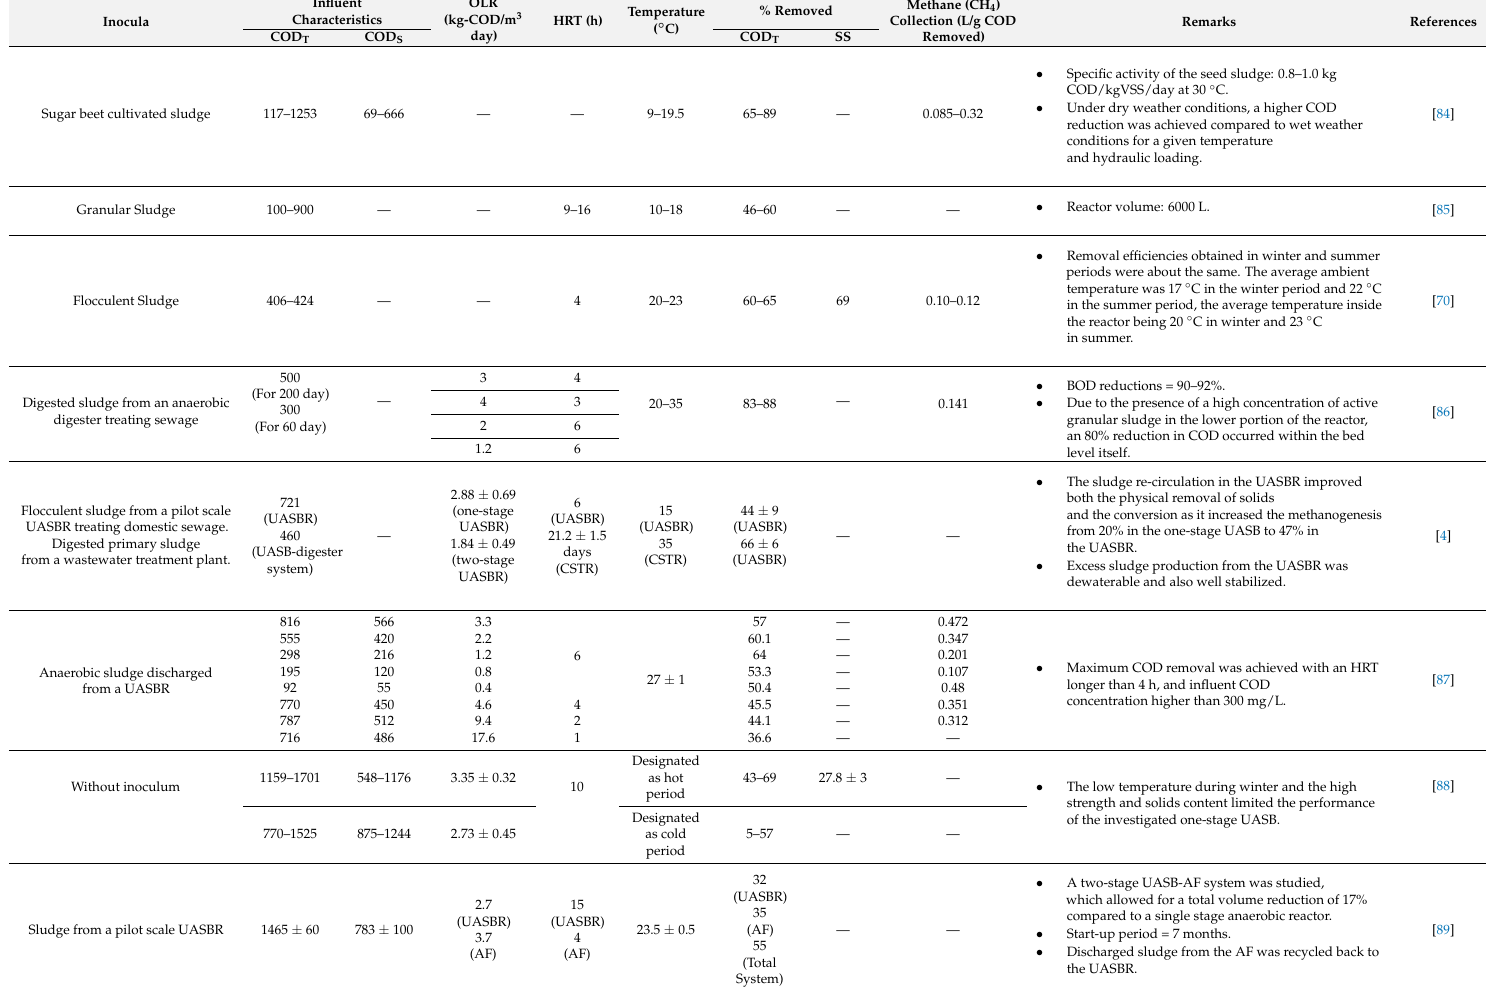
Table 2. Selected key operating parameters and performance of laboratory-scale (reactor size range 55–6000 L) UASB systems studied by different